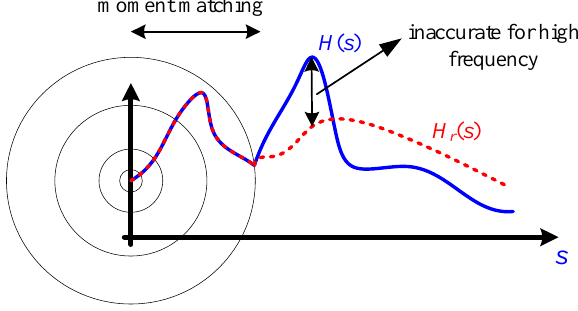
Figure 1. Taylor expansion around s = 0.